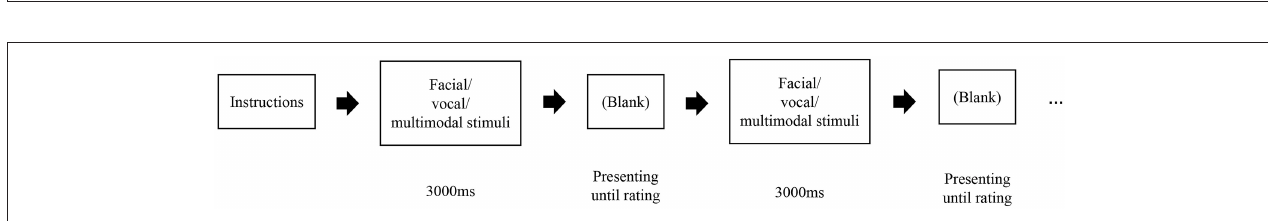
FIGURE 2 | The procedure of presenting facial/vocal stimuli in Study 1 and multimodal stimuli in Study